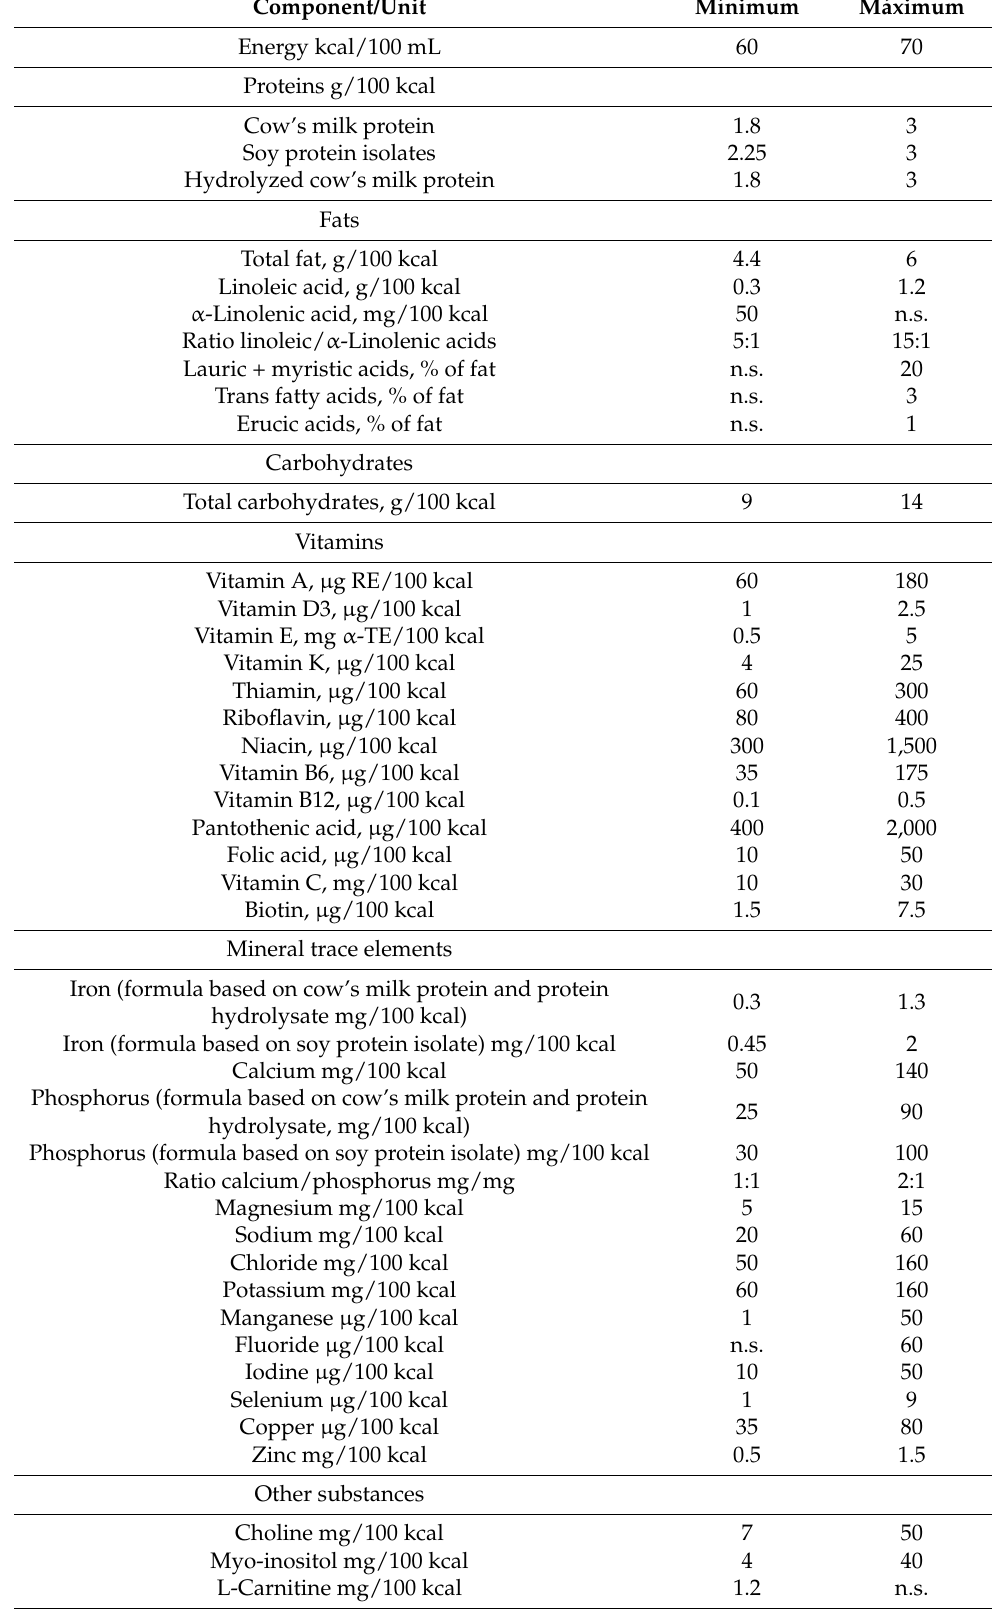
Table 1. Recommendation on the composition of infant formulae by an international expert group coordinated by the ESPGHAN